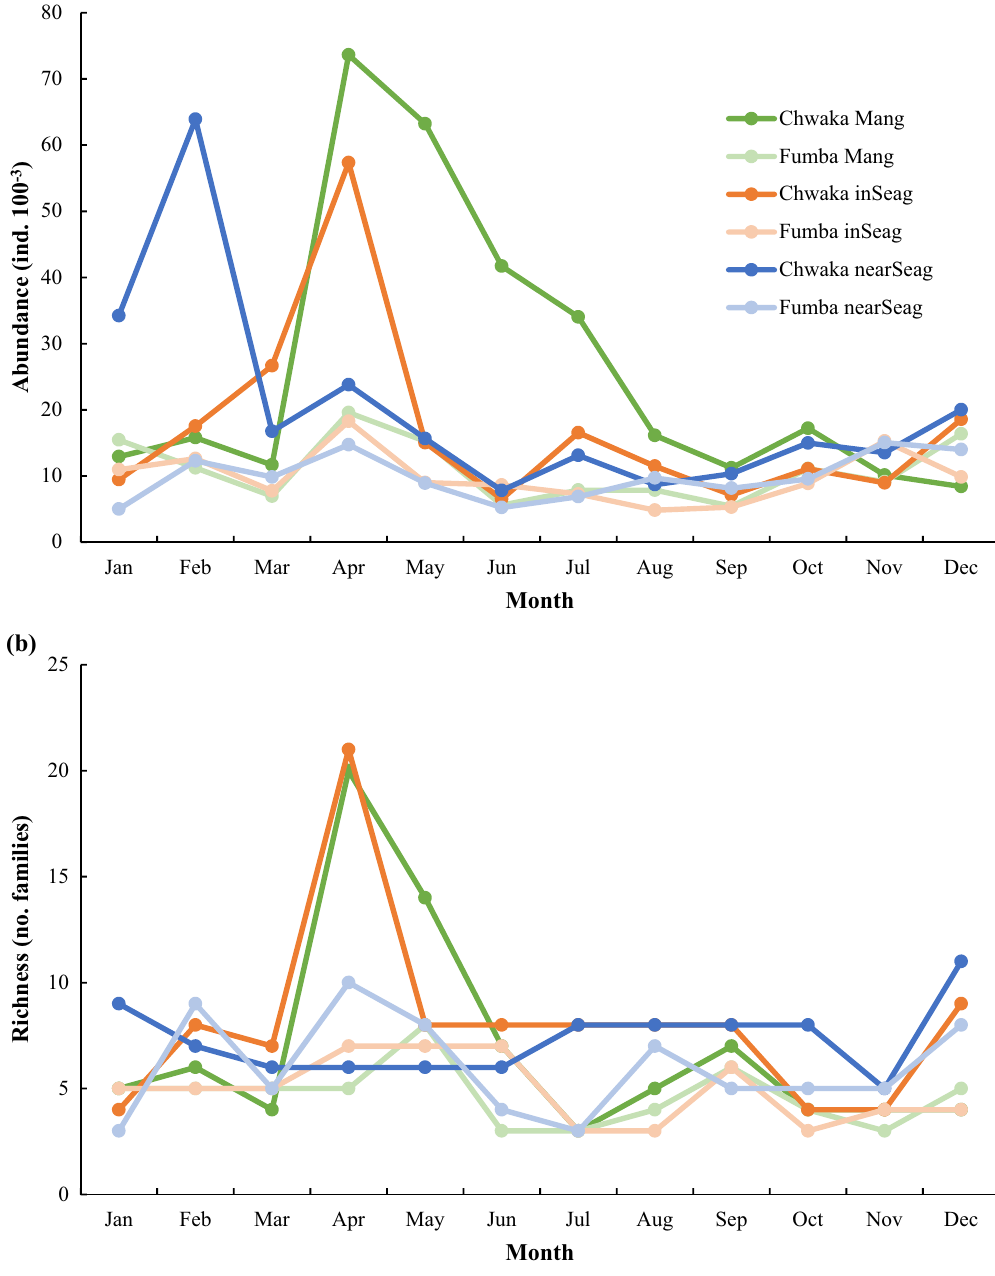
Figure 4. Mean abundance of fish larvae ( a ) and mean number of fish larvae families ( b ) in mangrove creeks (Mang), inshore seagrass meadows (inSeag) (located adjacent to mangroves) and nearshore seagrass meadows (nearSeag) (located in-between mangroves and coral reefs) in Chwaka Bay (Chwaka) and Fumba recorded for each month during the whole sampling period (i.e. January–December